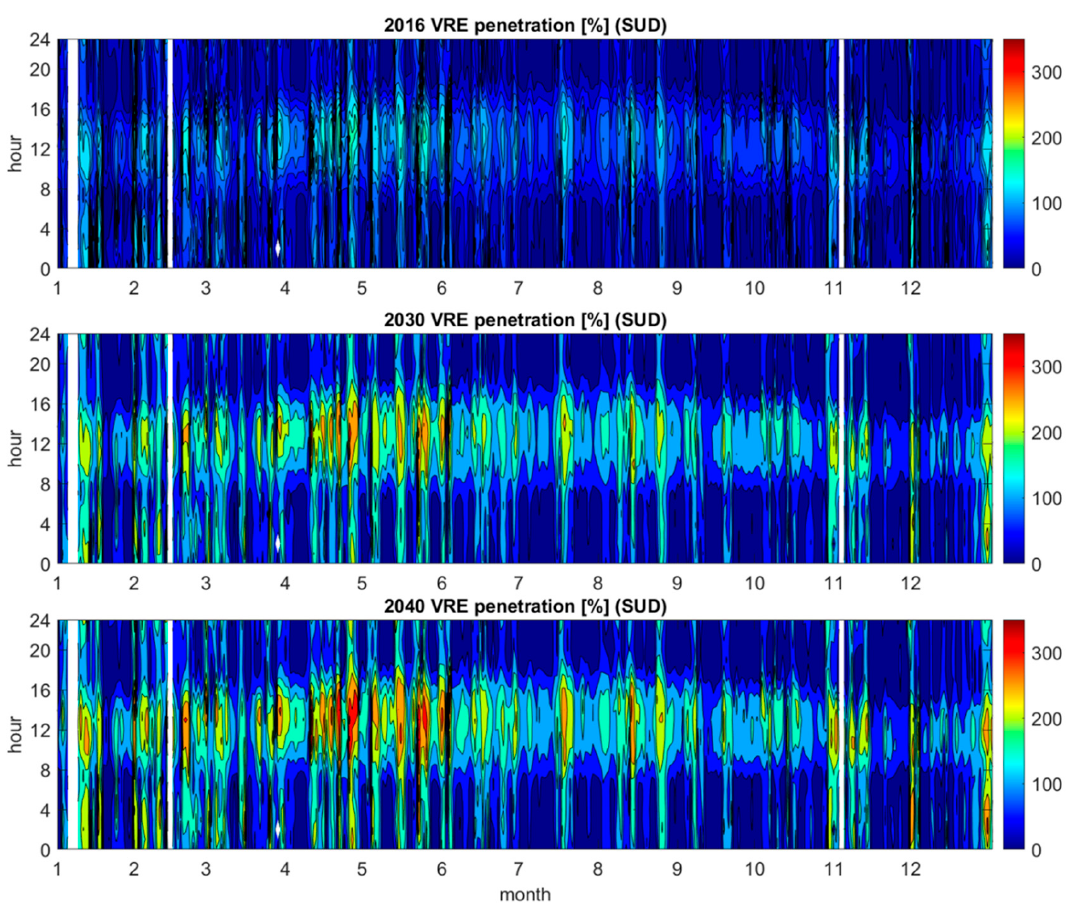
Figure 17. VRE penetration (ratio between VRE generation and demand) by 2016, 2030 and 2040 in the south zone. The unit in the color scale is the percentage of demand provided by wind and solar plants (% of the